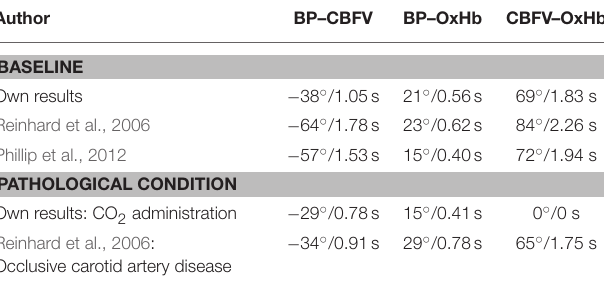
TABLE 2 | Mean phases (in angles) and time intervals between blood pressure (BP), cerebral blood flow velocity (CBFV), and oxygenated hemoglobin